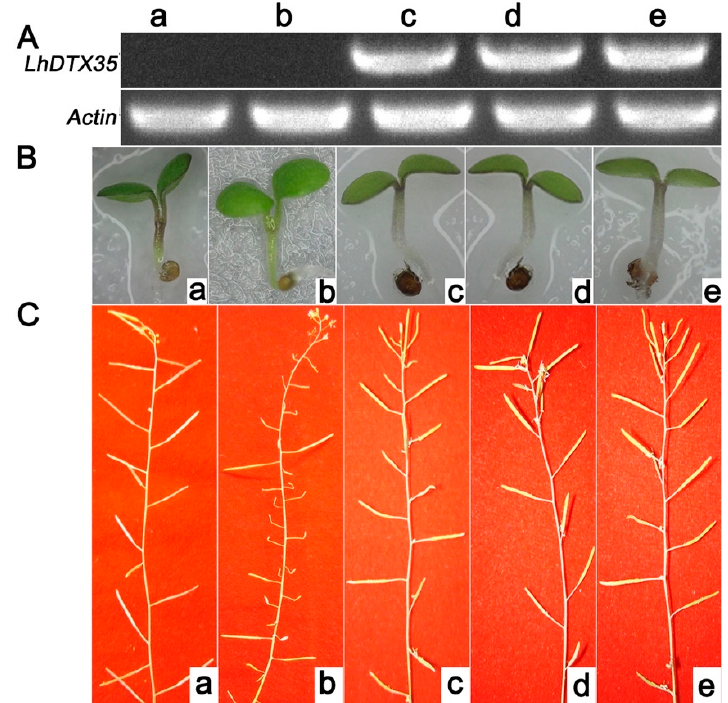
Figure 9. Functional complementation of the Arabidopsis DTX35 mutant with the LhDTX35 gene driven by the CaMV 35S promoter. ( A ) Expression of LhDTX35 in wild-type ( a ), mutant ( b ), and transgenic Arabidopsis seedlings ( c – e ). ( B ) Anthocyanin accumulation in wild-type ( a ), mutant ( b ), and transgenic Arabidopsis seedlings ( c – e ). ( C ) Silique fertility of wild-type ( a ), mutant ( b ), and transgenic Arabidopsis seedlings ( c – e ).